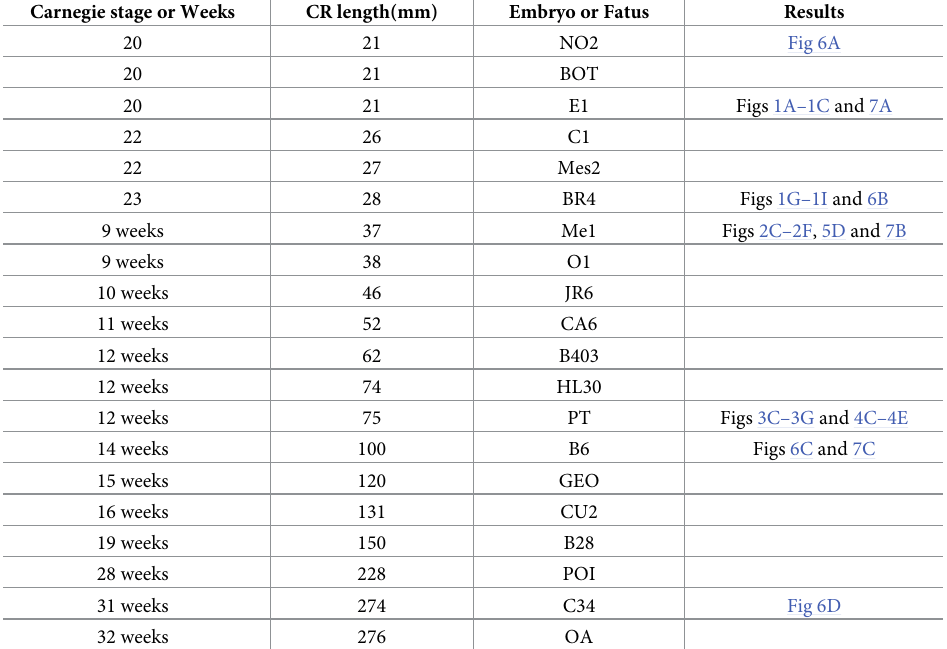
Table 1. Details of the embryonic